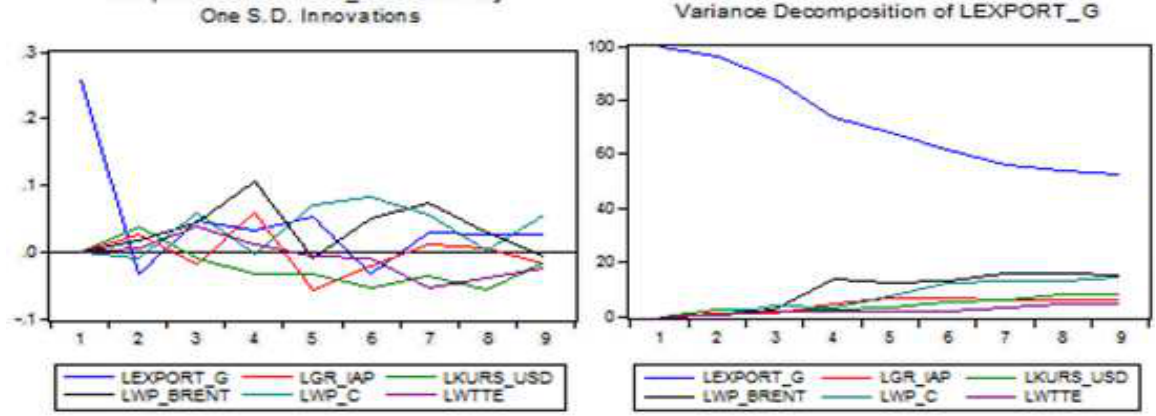
Fig. 5. The function of impulse response and the graph of decomposition exports of goods in Sumy region (LExport_G)